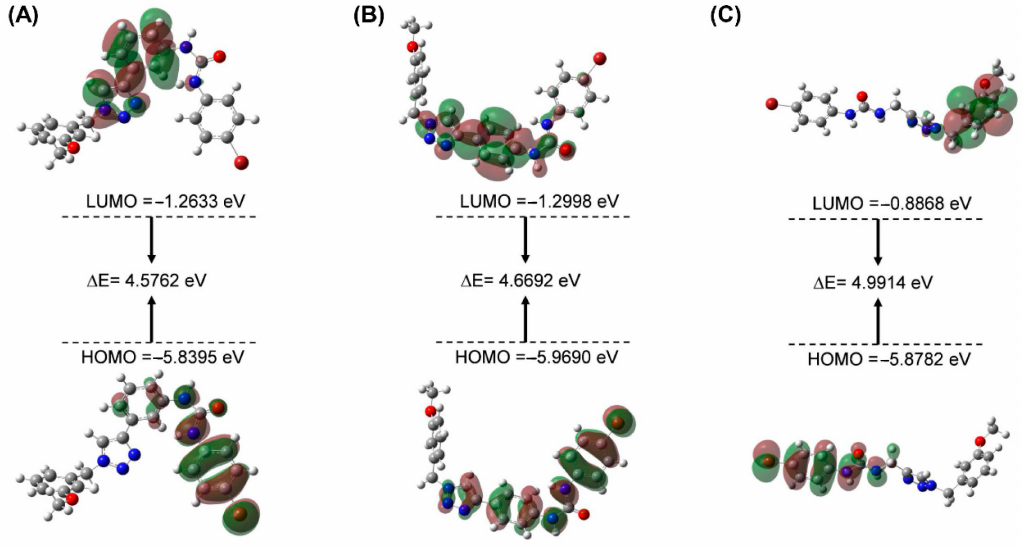
Table 3. Molecular frontier orbital parameters of compounds 3a , 5e and 7f.